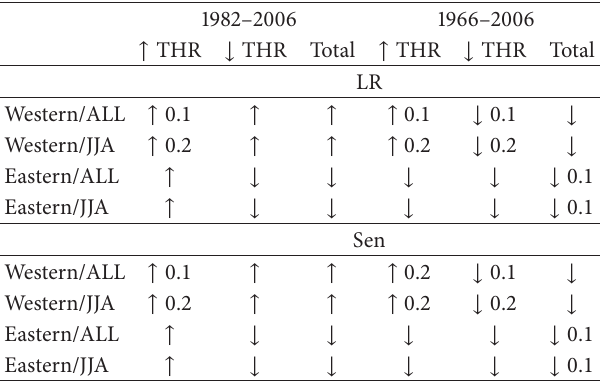
Table 4: Number of events above and below THR 1982–2006 and 1966–2006 for both regions and ALL and JJA data. 0.1 (0.2) denotes trend significant at 0.1 (0.2)